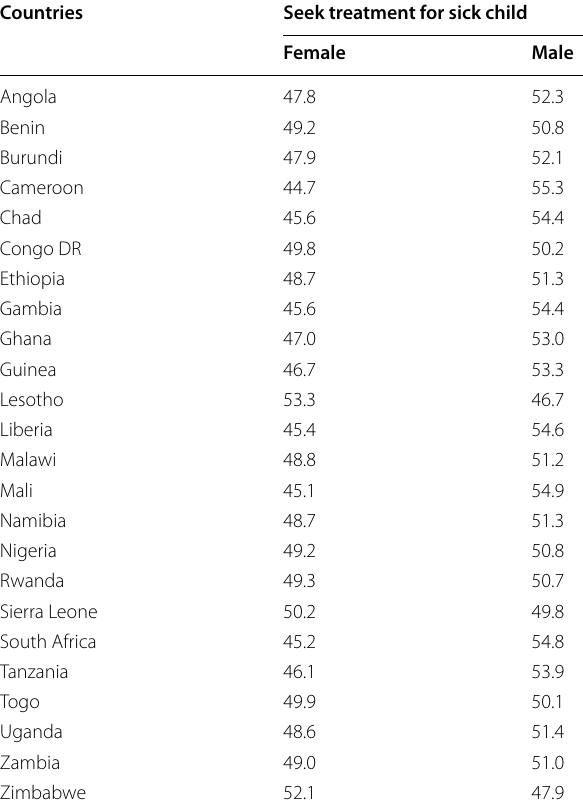
Table 1 Prevalence of health care seeking behaviour for